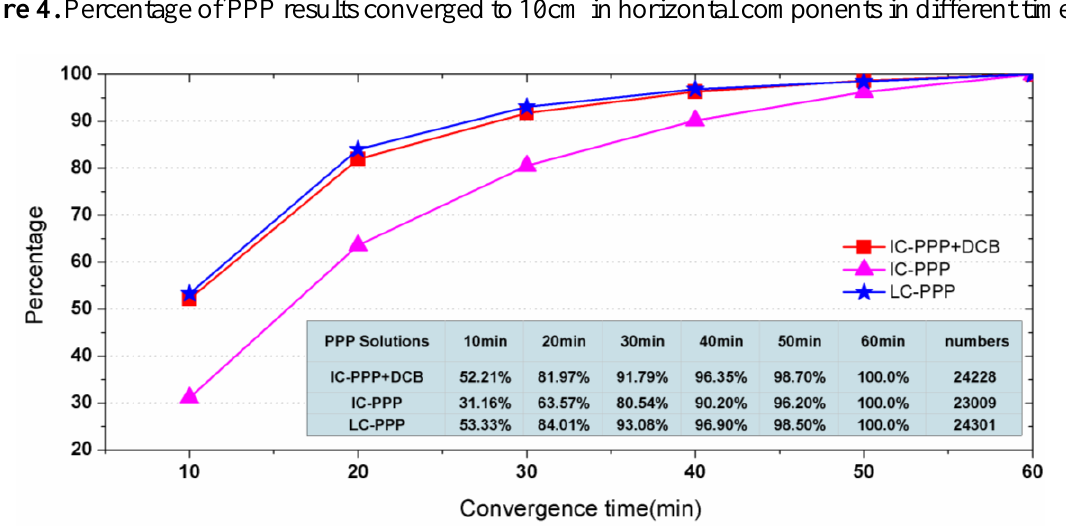
Figure 4. Percentage of PPP results converged to 10cm in horizontal components in different time spans.